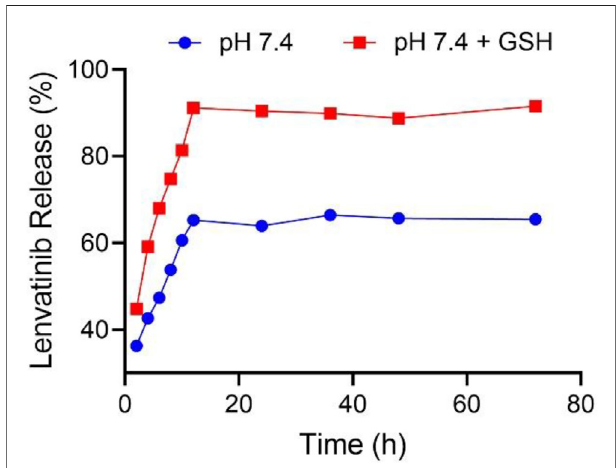
FIGURE 4 | NG/LEN released LEN at the presence or absence of 10.0 mM GSH in pH 7.4 PBS. Each set of data is represented as mean ± SD ( n (cid:1) 3).